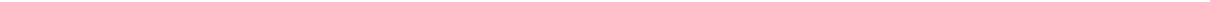
Figure 6 | Abrogation of pol g SUMOylation leads to replication defects in response to mild replication stress. ( a , b ) XPVcells stably expressing pol Z WT or pol Z K163R were treated with 0.3 m M APH for 6 or 24h and processed as described in Fig. 4a–d. The a panel shows representative images after 24h